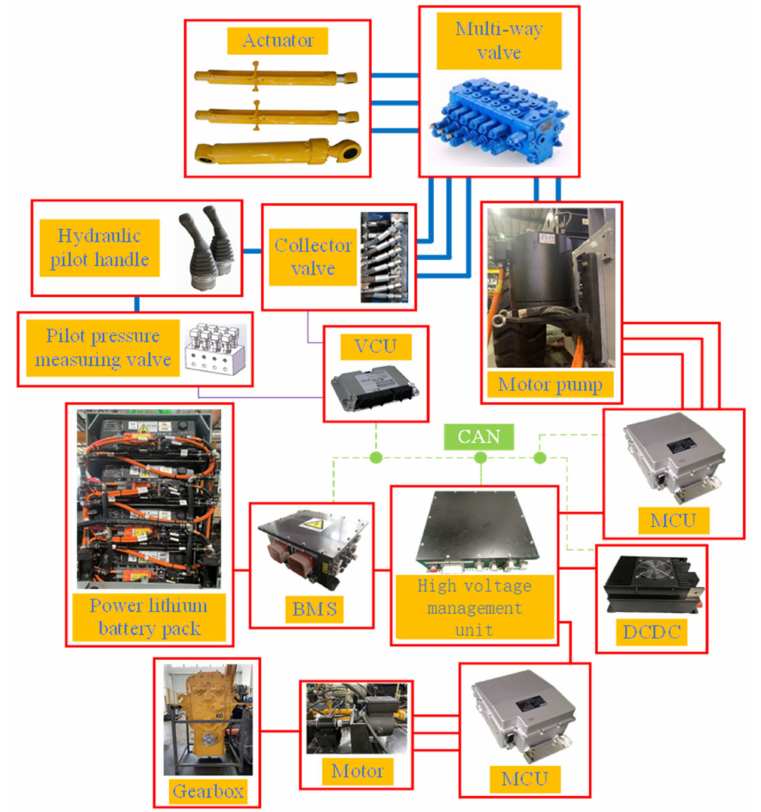
Figure 17. System structure diagram of the pure electric loader.